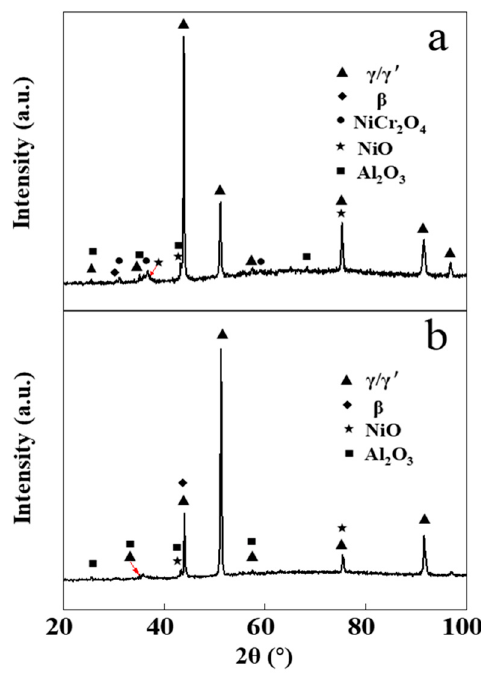
Figure 7. XRD patterns of the NiCrAlY bond coat before and after a high-current pulsed electron beam irradiation with static oxidation at 900 °C for 200 h: ( a ) nonirradiated, ( b ) 18 J/cm 2 .